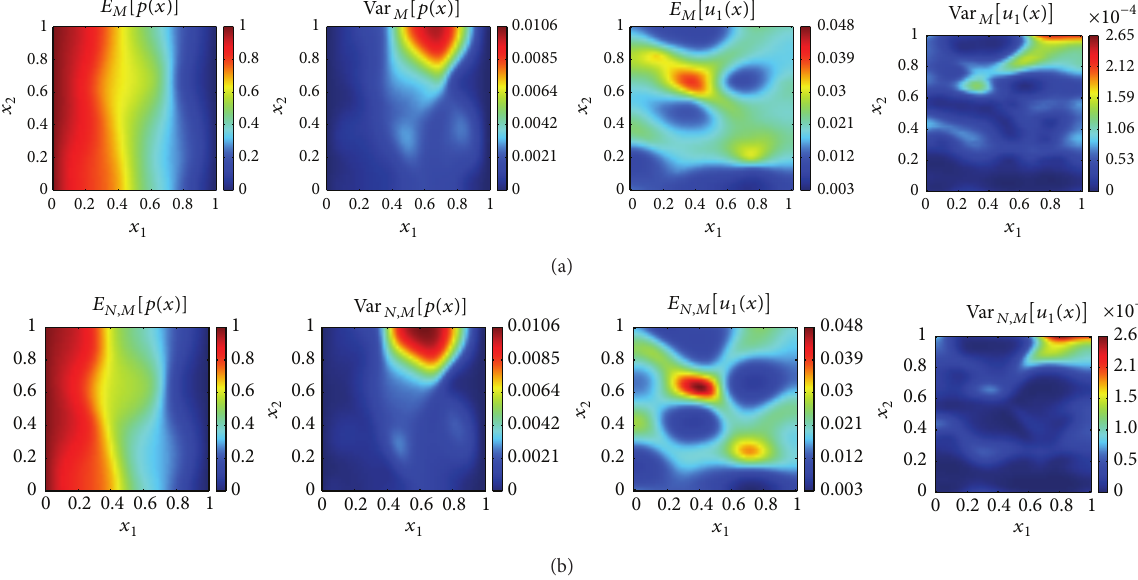
Figure 5: Conditional simulations with SGS-MC (a) and KL-MC (b) with 𝑀 = 6400 , 𝑁 𝑚 = 30